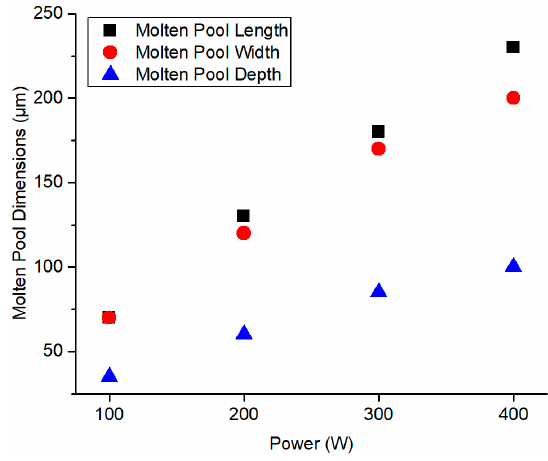
Figure 10. Predicted molten pool dimensions under various laser power settings. The laser scanning velocity was 600 mm/s.